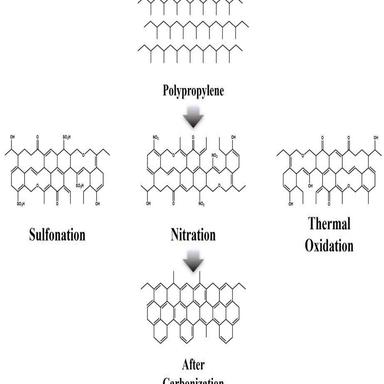
Proposed schematics of the fabrication process for anode carbon materials derived from waste mask.